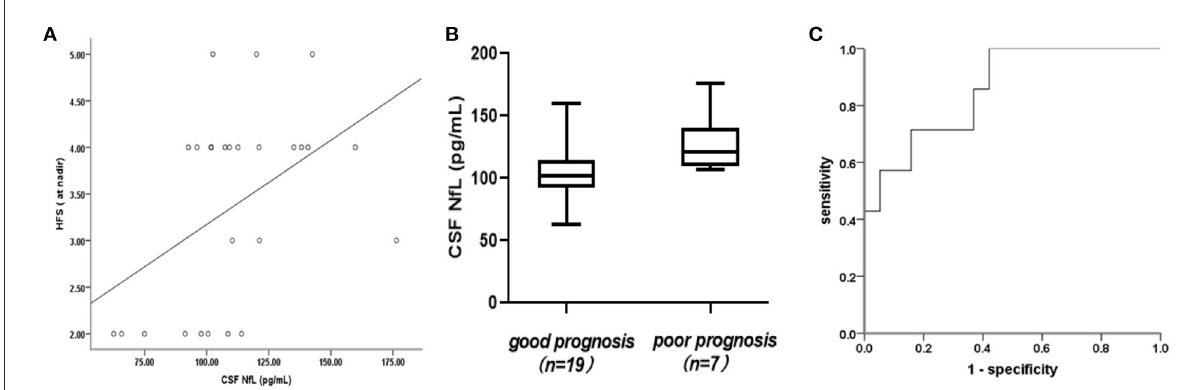
FIGURE2 (A) Association of cerebrospinal fluid neurofilament light chain (CSF-NfL) concentrations upon admission with the Hughes Functional Score (HFS) calculated at nadir with a Spearman’s correlation coefficient r s of 0.461 ( p = 0.018). Each dot in the scatter plot represents a sample. (B) CSF-NfL levels on admission in patients who were good or poor prognoses at 1 month after symptom onset. Box plots indicate median and IQR with whiskers extending 1.5 times the IQR. (C) Receiver operating characteristic (ROC) curve derived from logistic regression (with age as a covariate) was used to analyze the potential predictive value of CSF-NfLlevels with respect to unable to walk unaided (Hughes grade of 3 and more).